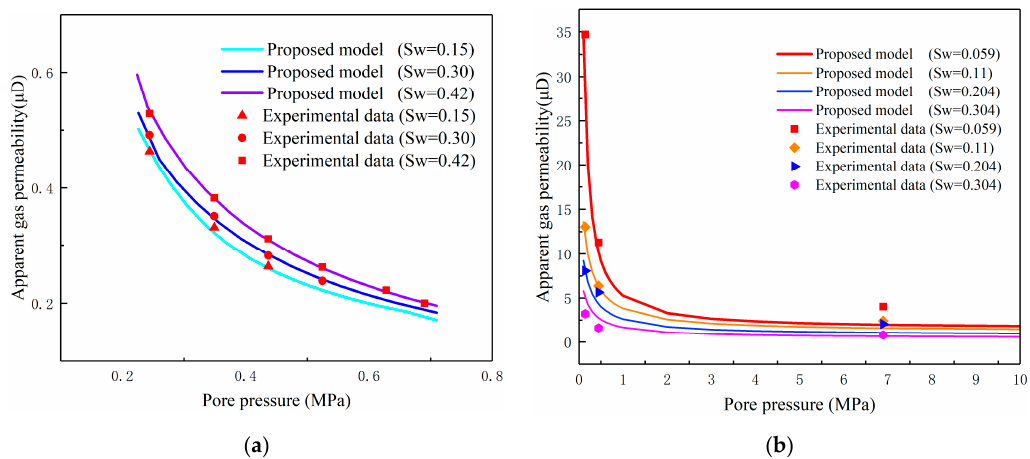
Figure 5. Model result compared with experimental data from literature of ( a ) Wu ( b ) Rushing.